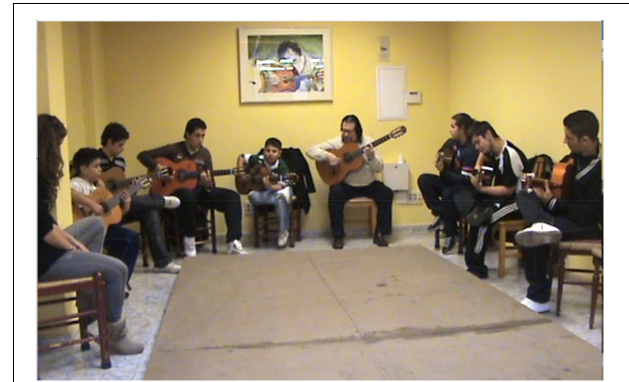
FIGURE 3 | Daily group flamenco guitar class in the Escuela del Maestro Entri in Cañorroto, Carabanchel, Madrid,